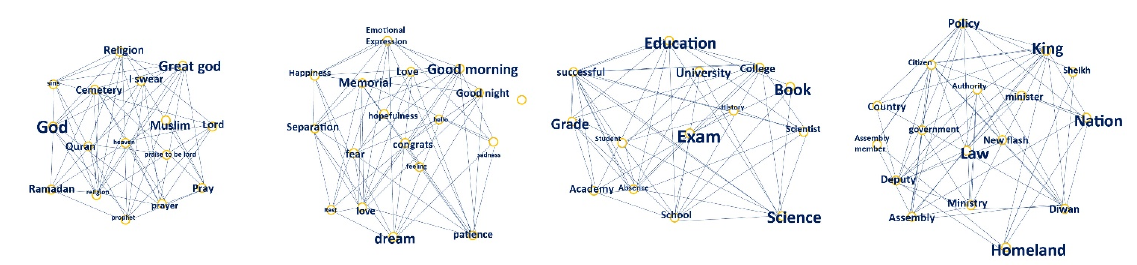
Figure 7. The frequency of words-related topic.